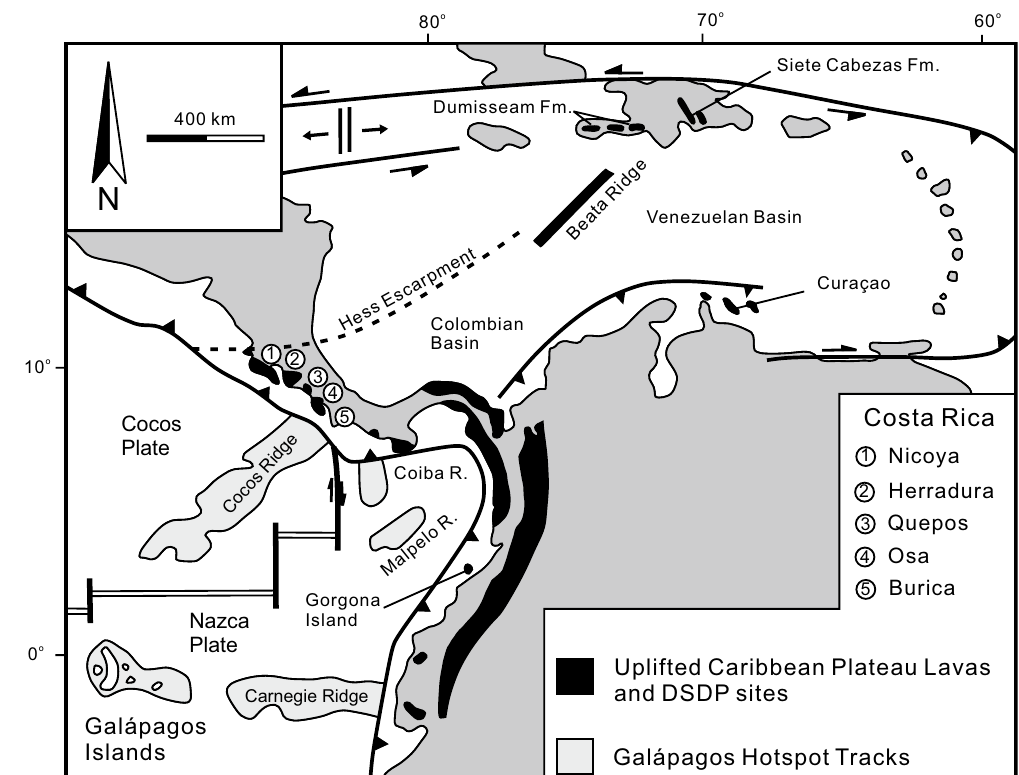
Figure 4. Distribution of the Caribbean plateau rocks and the locations of the Galápagos Islands, Carnegie Ridge, and Cocos Ridge 71 .